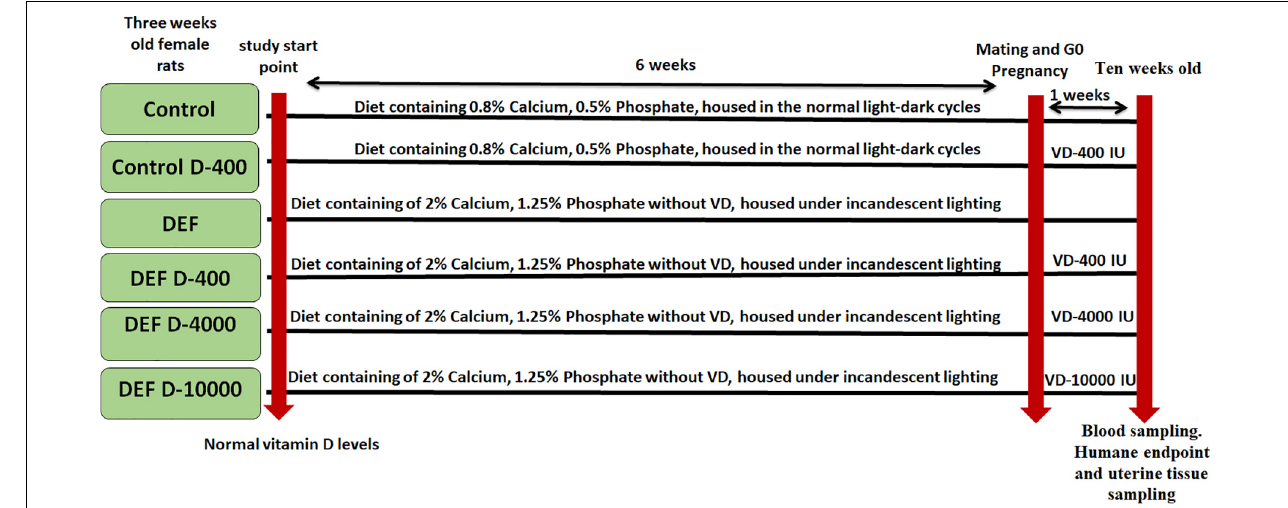
FIGURE 1 | A timeline represents the included groups with the scheduled experimental interventions. D: refers to vitamin D (VD) supplementation in different doses equivalent to 400, 4,000, and 10,000 IU. DEF: refers to VD deficiency.